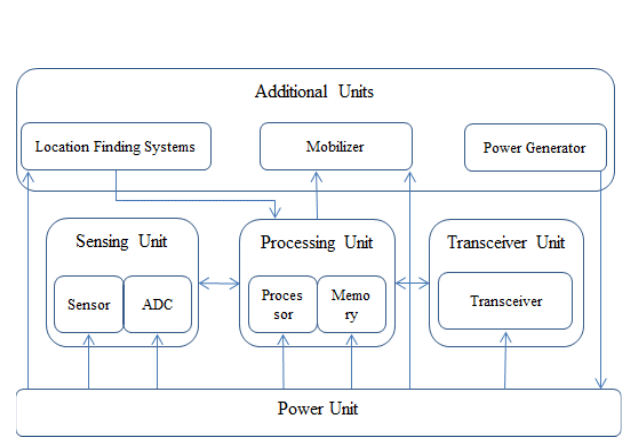
Figure 7. Architecture of Sensor Node [18] [19]